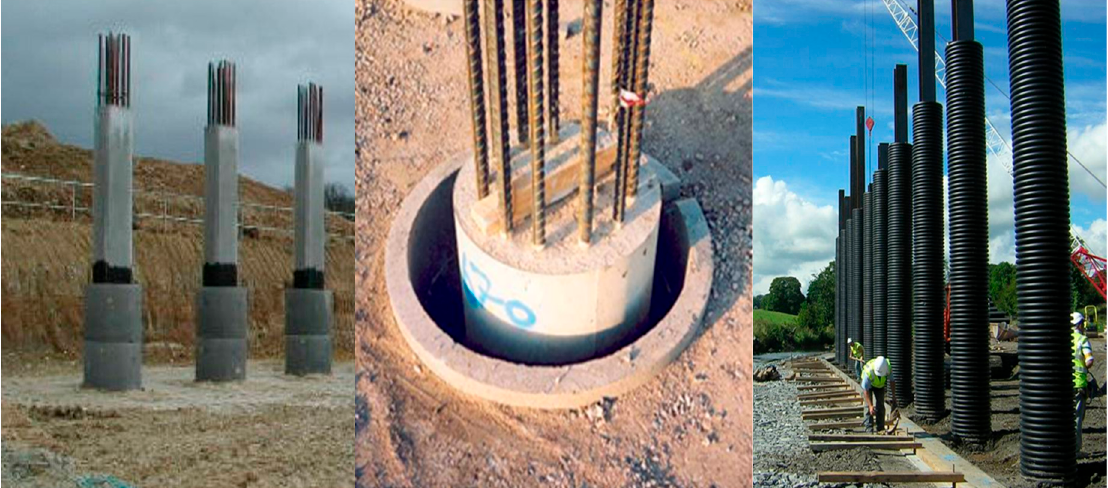
Figure 6. Sleeves around the piles.